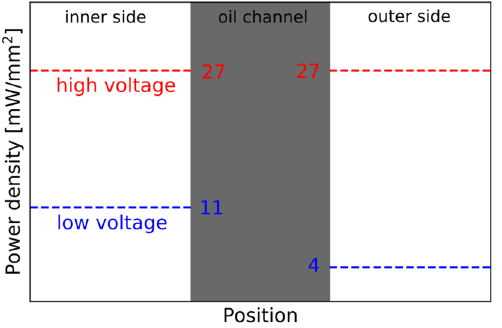
Figure 5. Schematic depiction of the average power densities on the two sides of the oil channel during the fragmentation. Note that the power density is the same on both sides of the channel in case of high voltage, but asymmetrical (and much lower) in low voltage